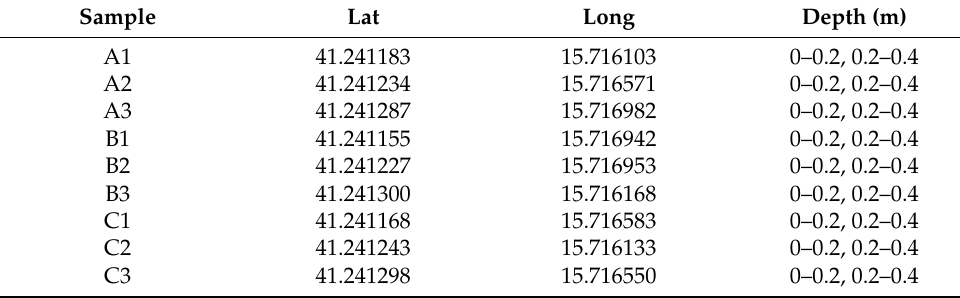
Table 5. Location of soil sampling in UTM